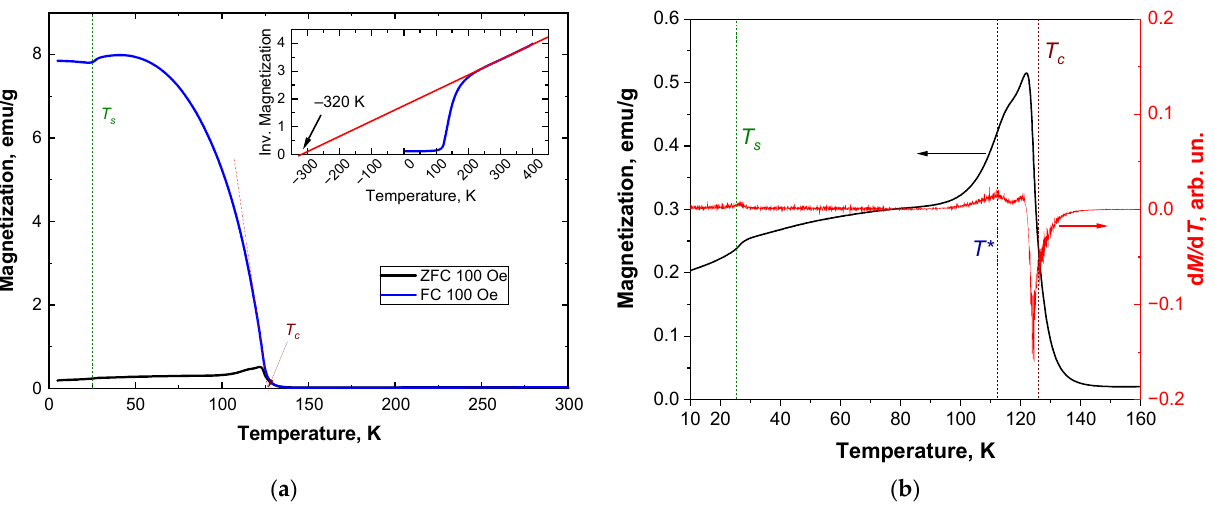
Figure 2. ( a ) Temperature dependencies of the magnetization recorded in the zero-field-cooled (ZFC—black curve) and in the field-cooled (FC—blue curve) regimes. ( b ) ZFC magnetization (black curve) and its first derivative (red curve). The inset in ( a ) panel shows the temperature dependence of inverse